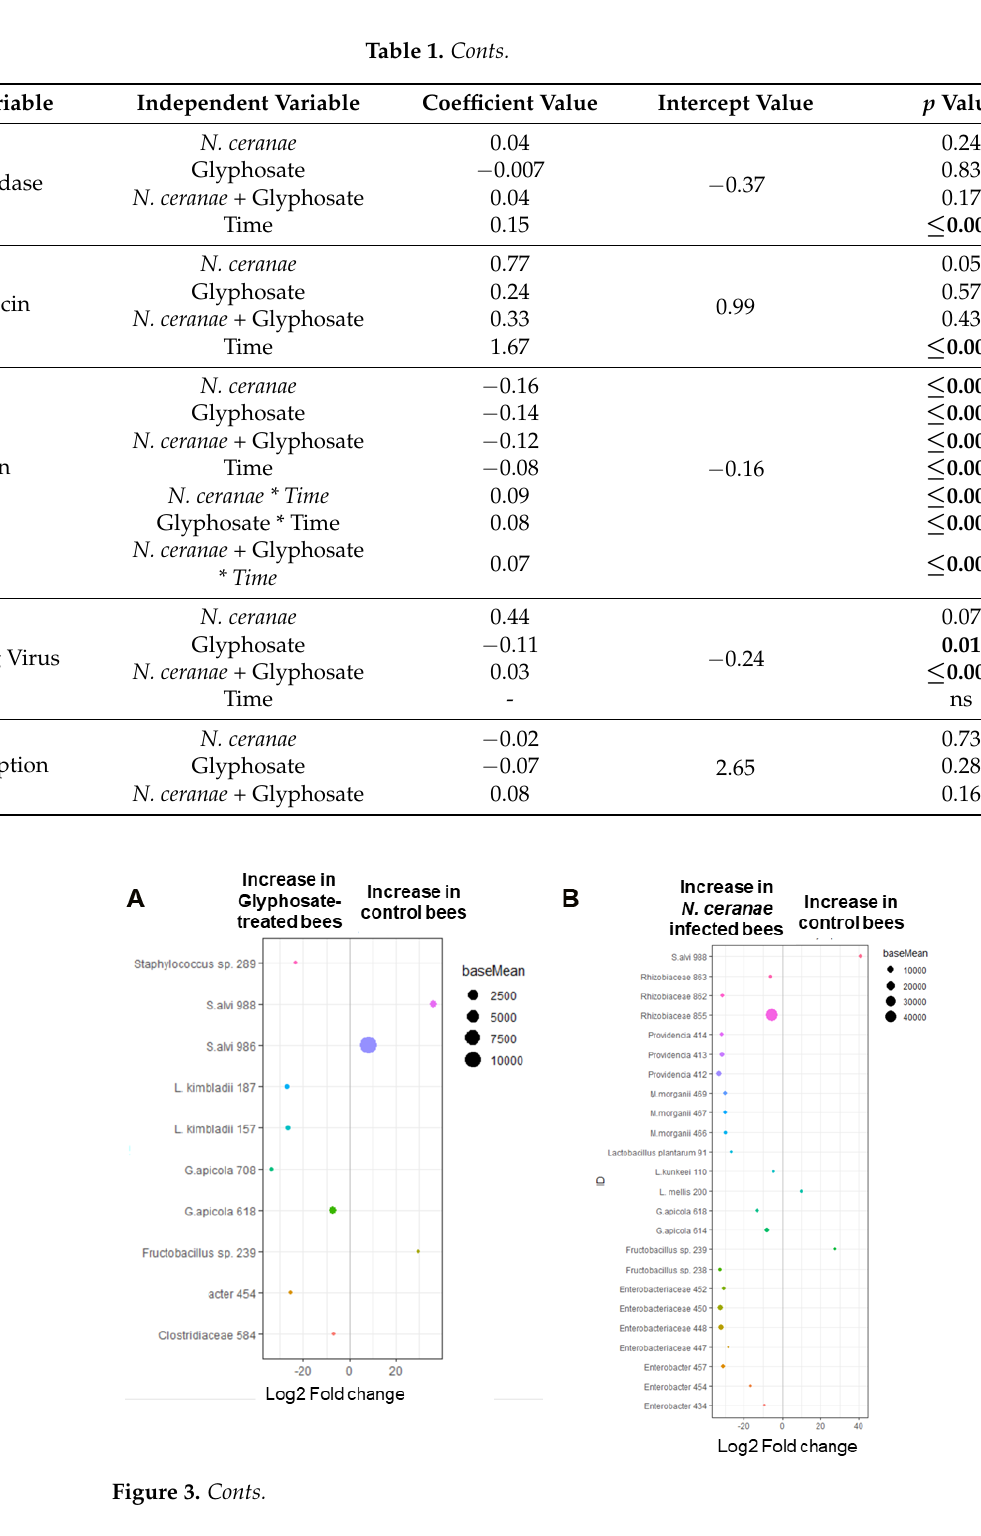
Figure 3. Impact of glyphosate, N. ceranae infection and both stress factors combined on the relative abundance of gut microbiota ASVs compared to control bees, analyzed using DESeq2. Ten honey bees (three/four bees per cage, from three cages) were individually analyzed per treatment. Only ASVs present in at least three individual samples and that show significant differences in relative abundance between groups are shown. ( A ) Comparison between honey bees subjected to chronic exposure to glyphosate (10 mg/L) for seven days and control bees; ( B ) Comparison between honey bees infected with N. ceranae (100,000 spores/bee at day 0) and control bees; ( C ) Comparison be- tween honey bees subjected to both stress factors combined and control bees. In ( A – C ) a negative value of log2 fold changes means a decreased abundance in control bees (increased in Glypho- sate/ N. ceranae or Glyphosate + N. ceranae groups) and a positive value means an increased abun- dance in control bees (decreased in treated groups). ( D ) Summary of the results of the pair-wise comparison between treated groups and control. Green indicates an increase in treated groups and red indicate a decrease in those groups.